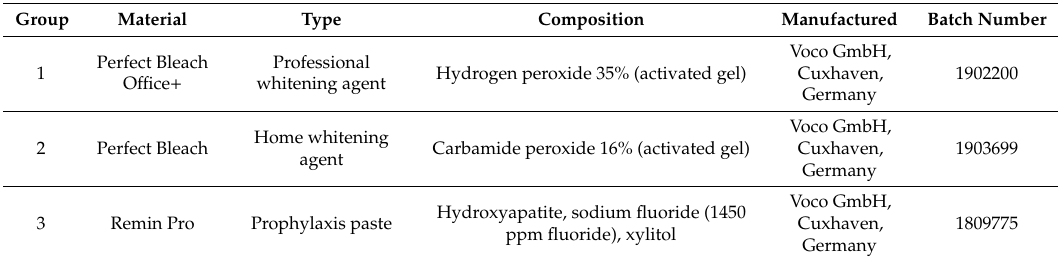
Table 1. Characteristics of the materials used in this